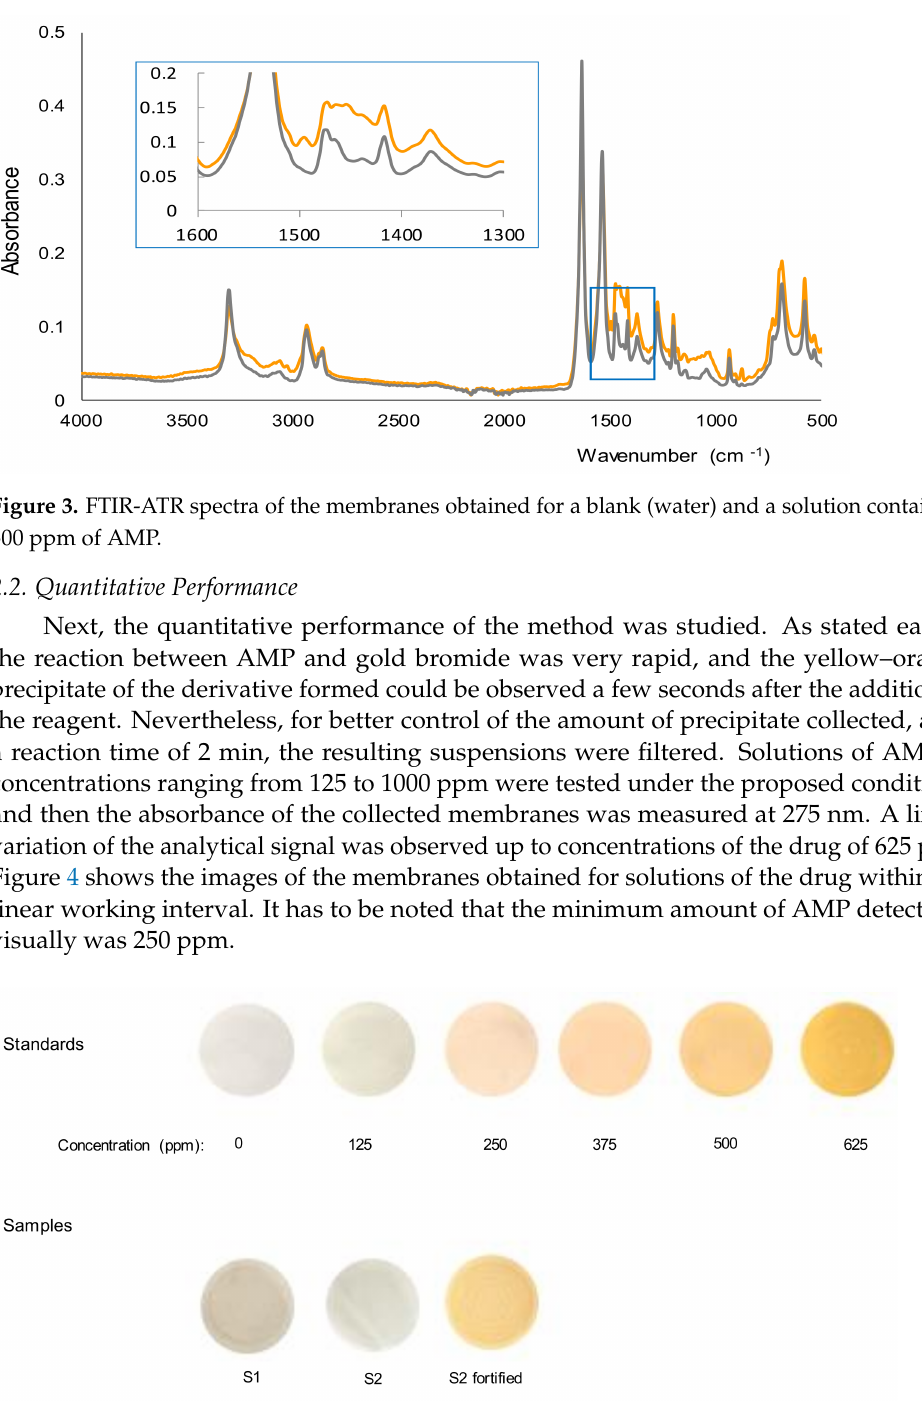
Figure 4. Images of the membranes obtained for the calibration solutions and for the drug-street